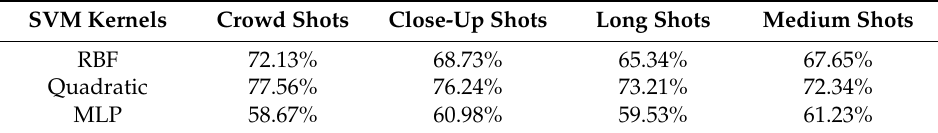
Table 5. Classification accuracy using SVM (Quadratic, MLP, and RBF kernels) with LBP.